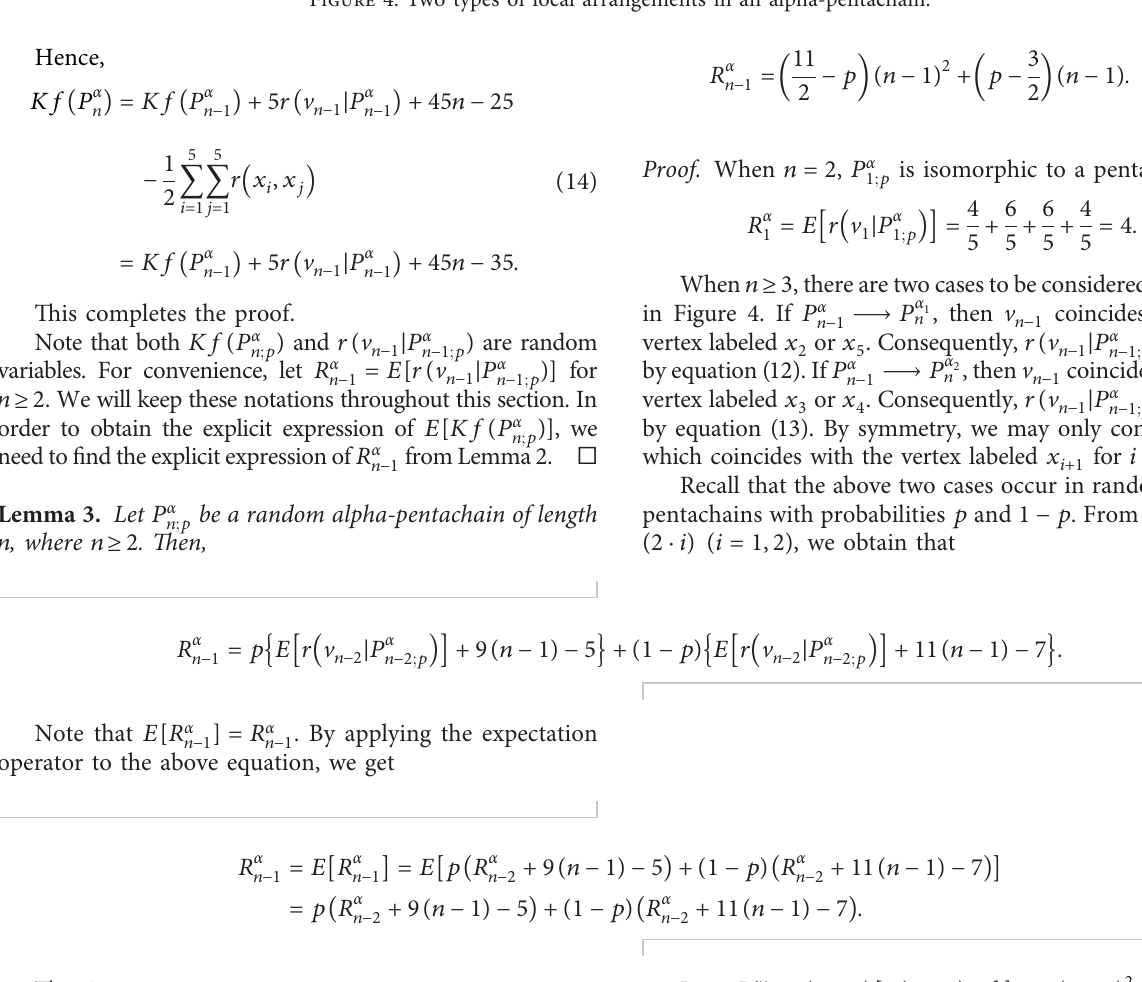
Figure 4: Two types of local arrangements in an